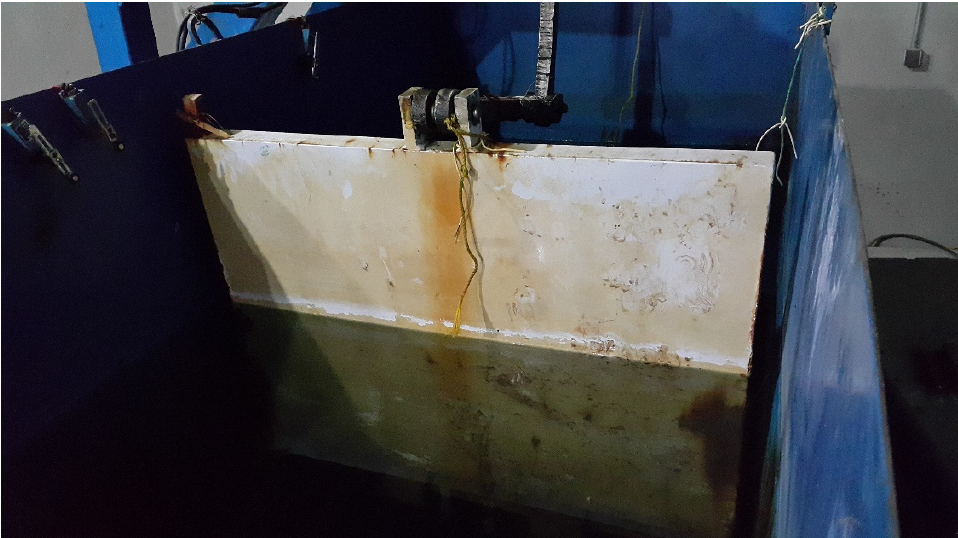
Figure 2. A view of the flap of the experimental wave